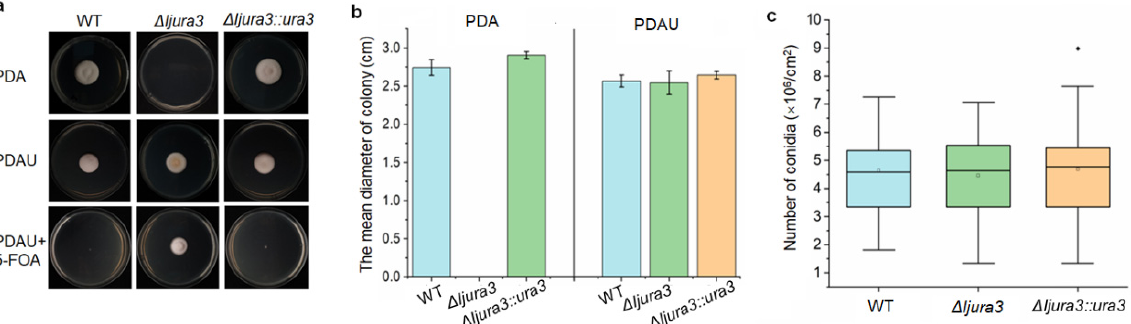
Figure 1. Comparison of cultural traits among the wild-type, Ijura3 mutant, and complementation ( Δ Ijura3::ura3 ) strains of I. javanica . ( a ) Colony grown on PDA, PDA plus 0.5 mg/mL uridine (PDAU), and PDAU plus 1 mg/mL 5-FOA. ( b ) Colony sizes of different strains on PDA and PDAU cultured at 25 °C for 7 days. Error bar represents the standard error of the mean. ( c ) Conidial production on PDAU after culture at 25 °C for 7 days. The marker (*) in Box-plot represents outlier. For ura3 gene complementation, the full length of Ijura3 gene with upstream and downstream flanking sequences (~4.1 kb) was amplified from the WT strain of I. javanica